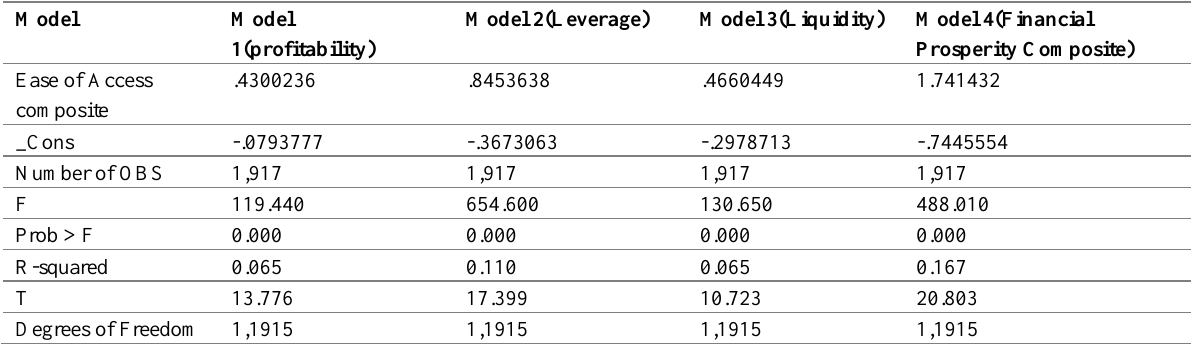
Table 1: Relationship between ease of access and financial